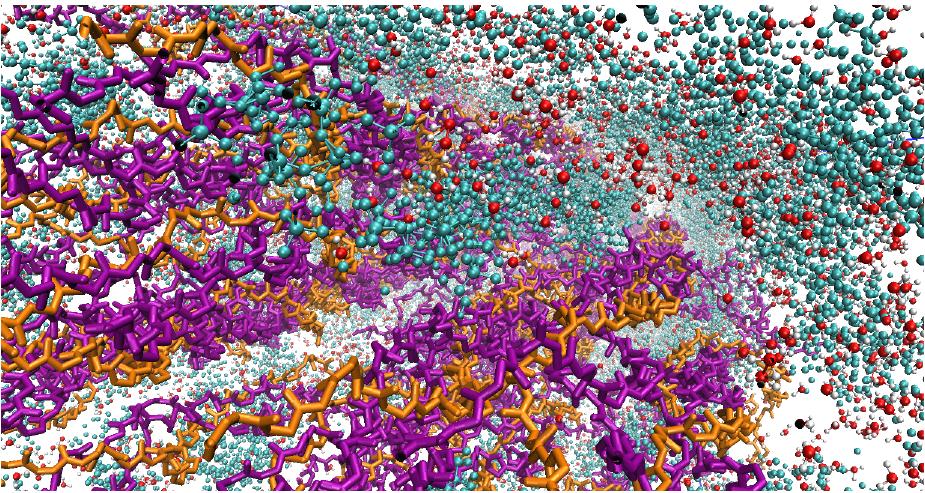
Figure 8. Zoomed view of a bone fiber in VMD. HA, H 2 O, and CLG molecules are shown in cyan, red, and purple (alpha-1 chains) and orange colors (alpha-2 chains),